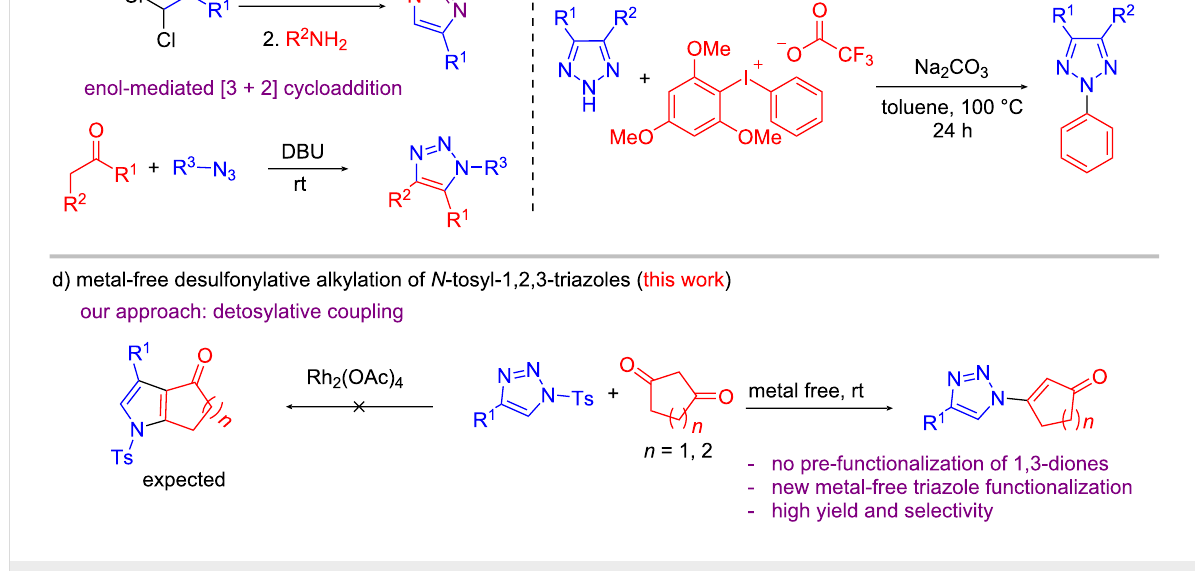
Scheme 1: Synthesis, functionalization and applications of